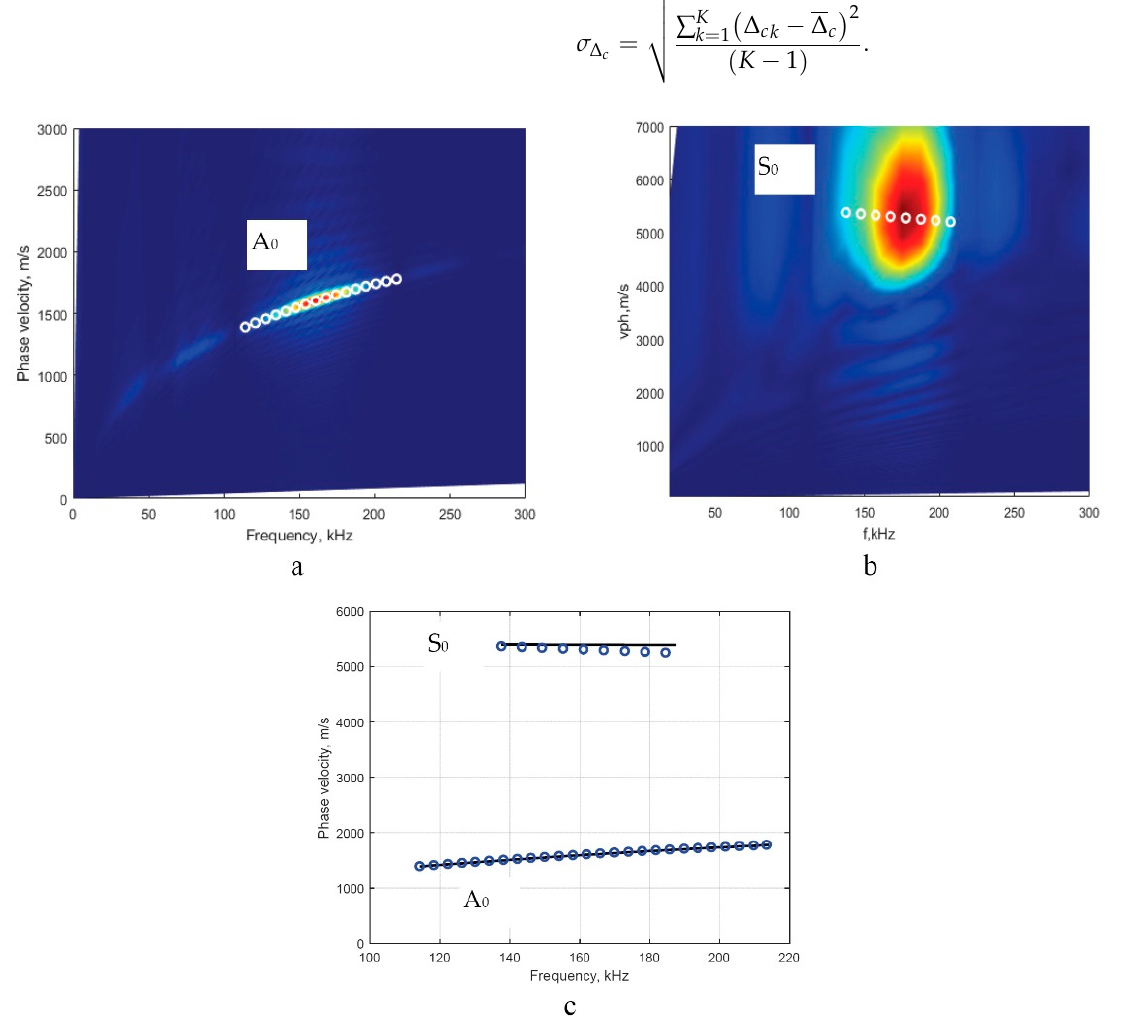
Figure 10. The phase-velocity dispersion curves are calculated by 2D-FFT and peak detection of the spectrum magnitude of 2D FFT (circles) for the A 0 ( a ) and S 0 ( b ) modes; and the dispersion curve segment obtained by using the analytical method (by computational package ‘DISPERSE’, the solid line) and reconstructed by using the proposed algorithm (circles) ( c ).